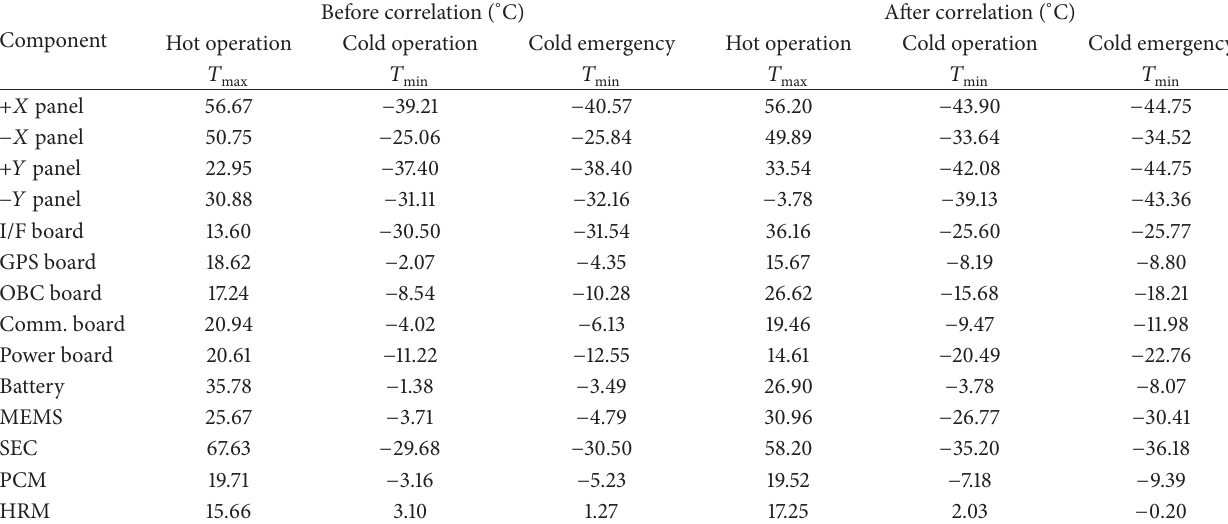
Figure 21: Before and after TMM correlation results of Δ𝑇 between test results and prediction by analysis ((a) cold balance correlation, (b) hot balance correlation). Table 9: On-orbit temperature prediction using the correlated TMM with TB